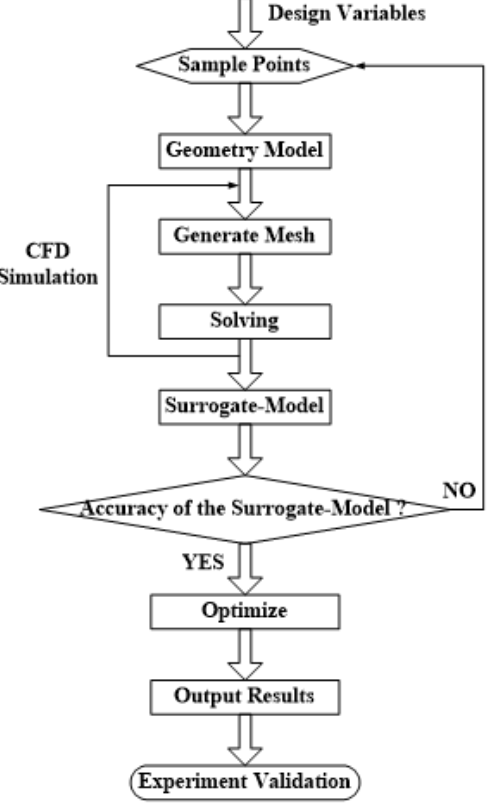
Figure 7. Flow chart of optimization. Optimal Latin Hypercube is a modified Latin Hypercube, in which the combination of factor levers for each factor is optimized, rather than randomly combined [18]. Optimal Latin Hypercube is a well-established DOE (Design of Experiment) method. A 20-level DOE study is carried out using the Optimal Latin Hypercube method for the above design variables, and the CFD simulations are conducted and 20 sets of response values are obtained, as shown in Table 5. The 20 levels of each design variable are divided between the lower and upper bounds of the design space. With these 20 design points, the minivan model is updated, meshed and solved for aerodynamic drag automatically. Then, DOE post-processing of the Pareto analysis is performed. To rank each parameter’s contribution, a Pareto plot for drag coefficient is given in Figure